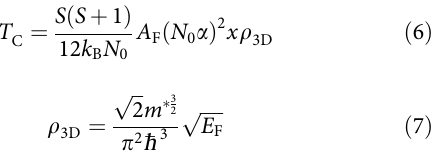
energy overlap has been proposed to induce the large s,p-d